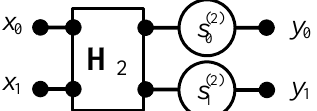
Figure 1. Signal flow graph of the algorithm for computing the 2-point